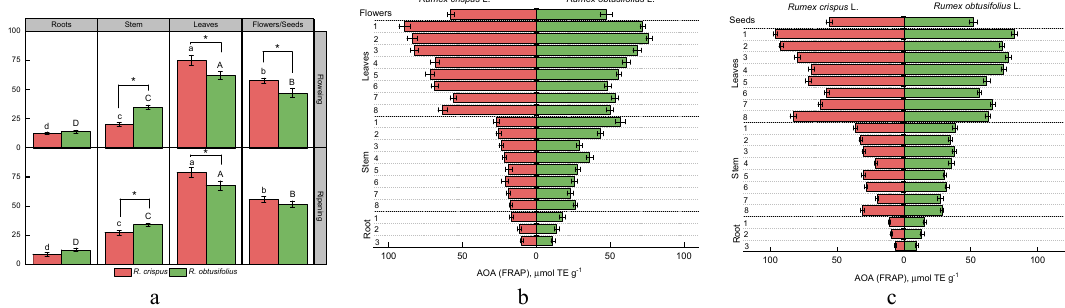
Figure 6. Antioxidant activity of extracts of various plant parts of R. crispus and R. obtusifolius (according to the 2,2’azinobis(3)ethylbenzthiazoline-6-sulfonic acid (ABTS) method) at the flowering and fruiting stages ( a ), antioxidant activity according for vertical distribution at flowering stage ( b ) and at fruiting stage ( c ). Different lower case letters indicate significant differences among plant parts of R. crispus ; upper case letters indicate significant differences among plant parts of R. obtusifolius ( p ≤ 0.05); asterisk * indicates significant differences among sorrel species ( p ≤ 0.05) based on post hoc Tukey’s tests separately for each growth stage.